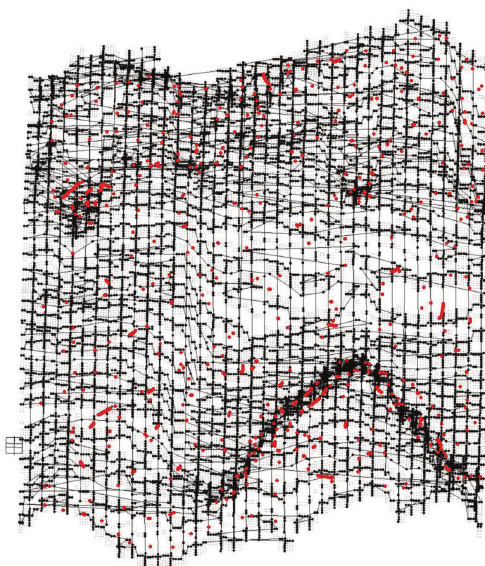
Figure 5: The point cloud of energy distribution section obtained by calculating kinetic energy values on each position point.